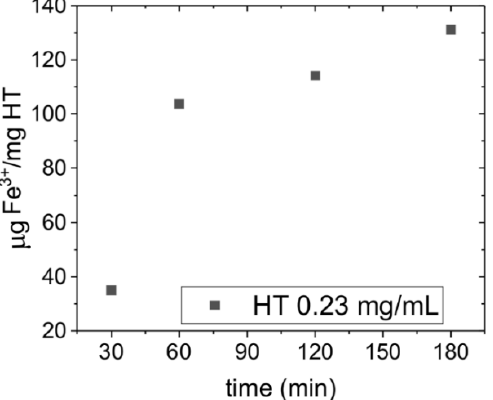
Figure 3. Q Fe values calculated as weight ratio ( µ g/mg) between dissolved iron ions and initial HT(H + ) versus ultrasonication